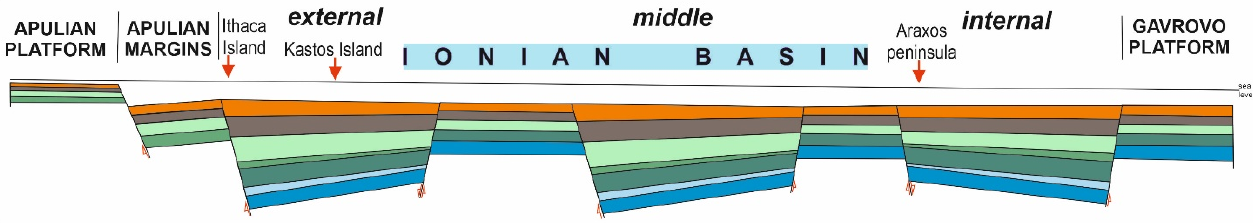
Figure 7. A schematic cross-section illustrating the Mesozoic depositional conditions of the Ionian basin, the geometry of troughs and highs, the impact of syn-sedimentary fault activity on depositional thickness, and the position of the studied areas, modified from [16].